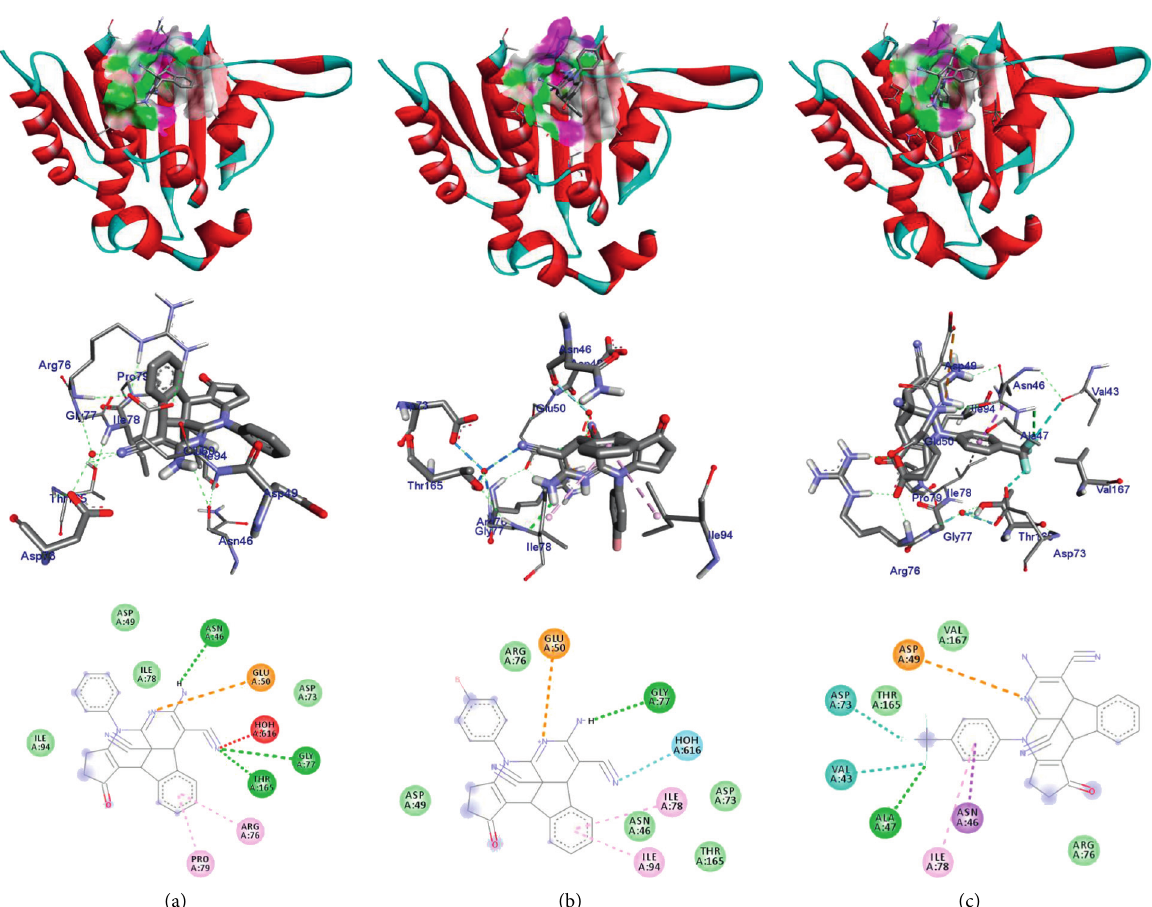
Figure 3: The 2D and 3D binding interactions of compounds 6b, 6h, and 6i (comparable to Ciprofloxacin) against E. coli DNA gyrase B (PDB ID: 6F86). 3D ribbon model shows the binding pocket structure of E. coli DNA gyrase B with compounds. Hydrogen bonds between compounds and amino acids are shown as green-dashed lines, and hydrophobic interactions are shown as pink lines. (a) 6b, (b) 6h, and (c)